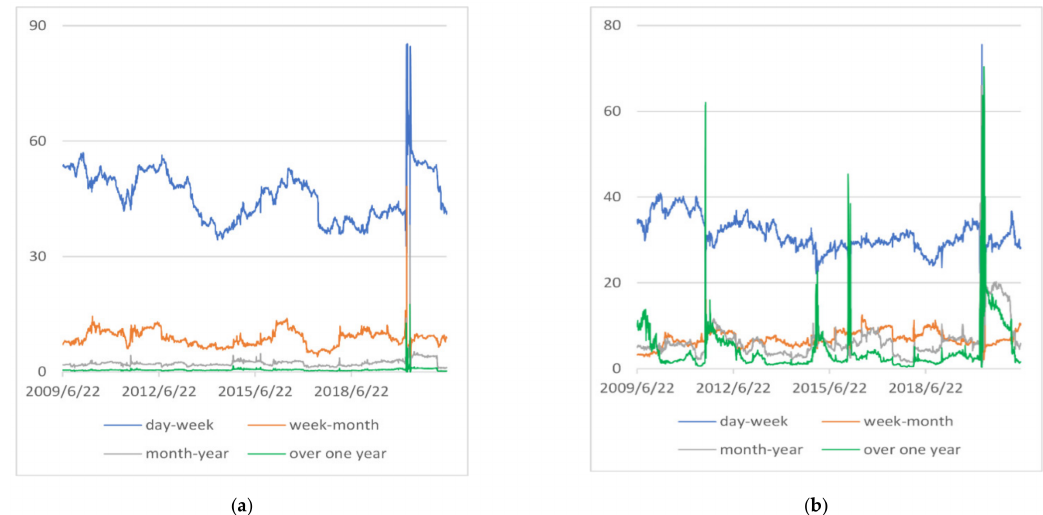
Figure 3. Total connectedness at different frequency bands in price return system and price volatility system. ( a ) Price Return System. ( b ) Price Volatility System.